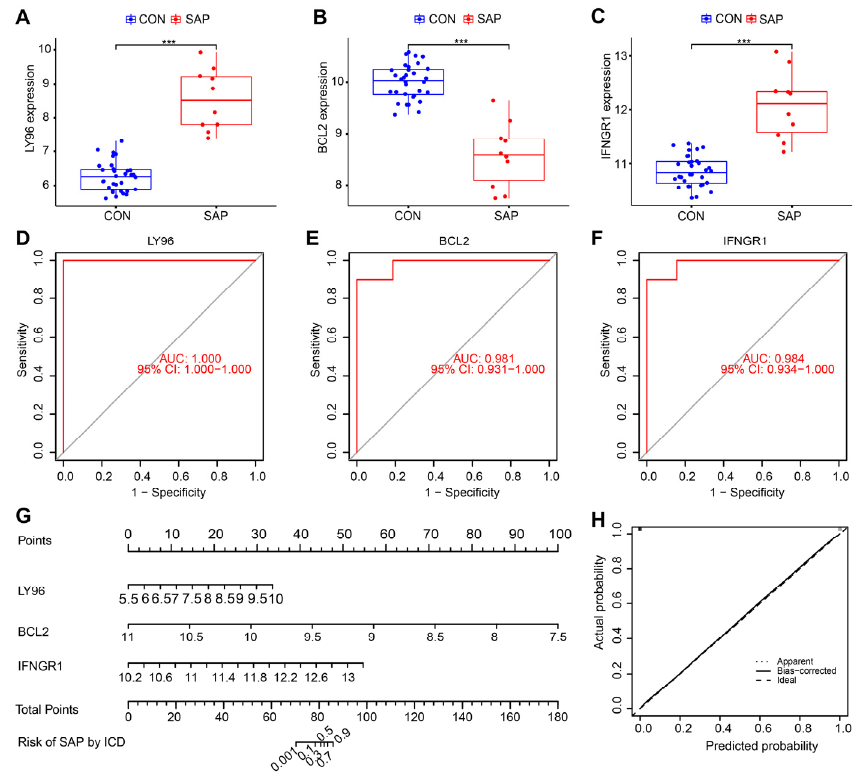
Figure 5. Validation of the importance of ICD in the pathogenesis of SAP through the hub gene. ( A – C ) Expression levels of three hub genes in SAP patients compared with healthy controls, *** p < 0.01. ( D – F ) ROC analysis of three hub genes. ( G ) Nomogram for measuring the signi fi cance of ICD in SAP based on hub genes. ( H ) Calibration curve plot for the nomogram. The X-axis represents the predictable probability, and the Y-axis represents the actual probability. Perfect prediction corre- sponds to the ideal dashed line. The apparent dashed line represents the entire queue, bias-corrected solid line is bias-corrected by bootstrapping (1000 repetitions) and represents the observed perfor- mance of the nomogram.